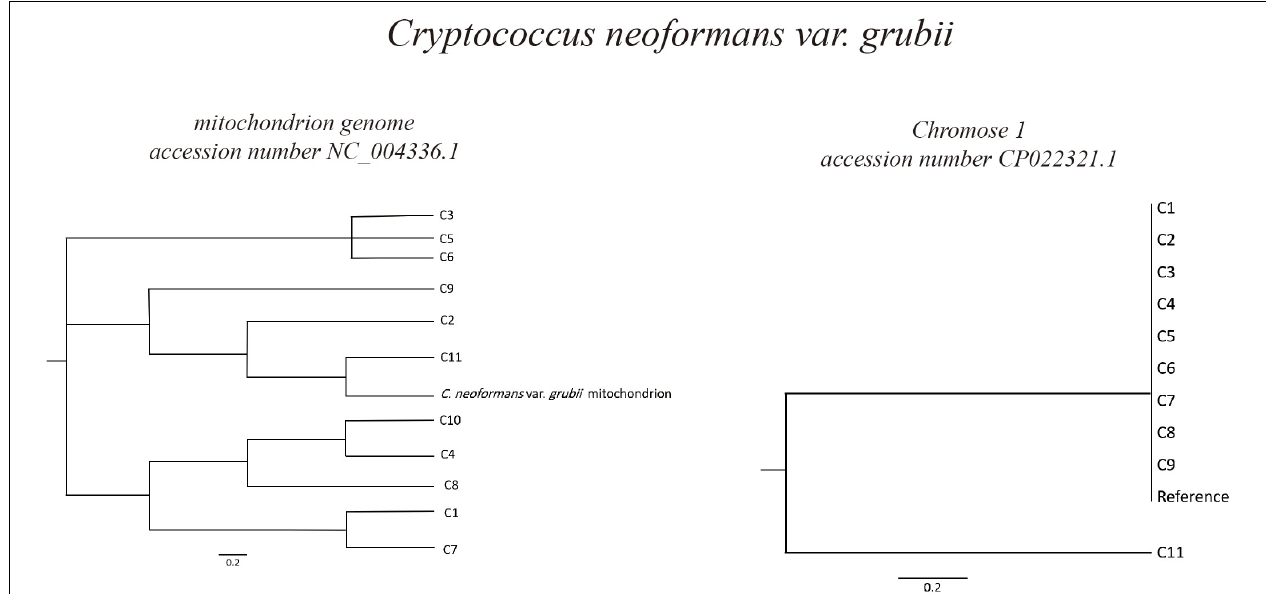
FIGURE 2 | Phylogeny of Cryptococcus neoformans var. grubii isolates. Sequence read analysis was done using CSI Phylogeny (Center for Genomic Epidemiology, Denmark). CSI Phylogeny calls SNPs, filters the SNPs, does site validation, and infers a phylogeny based on the concatenated alignment of the high-quality SNPs. The Cryptococcus neoformans var. grubii mitochondrion and chromosome 1 reference sequences (accession number NC_004336.1 and CP022321.1, respectively) were used for sequence comparison and variant calling. Phylogeny analysis showed high degree of similarity of most of the isolates (10 out of 11) to Cryptococcus neoformans var. grubii chromosome 1, while analysis based on sequences comparison to the mitochondrion genome showed varied degrees of similarities.